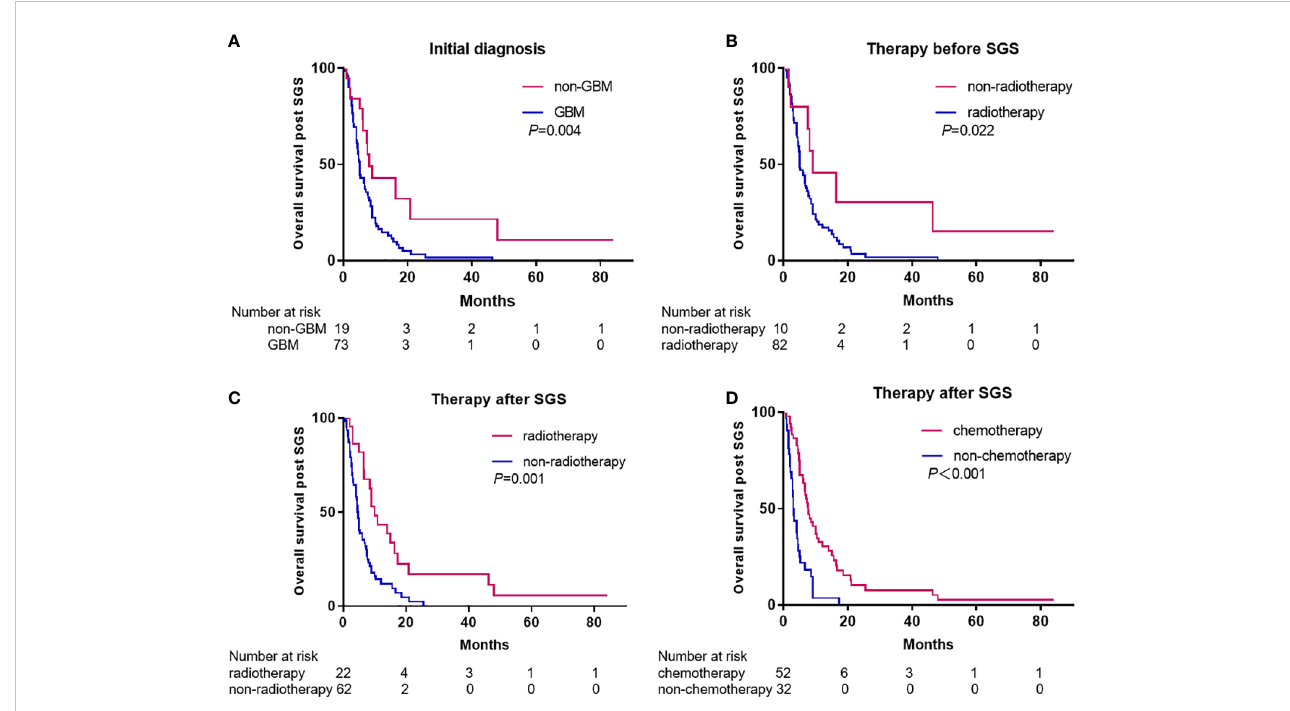
FIGURE 3 Kaplan-Meier estimates of overall survival post SGS diagnosis strati fi ed by initial diagnosis (A) , therapy before SGS (B) , and therapy after SGS (C, D)